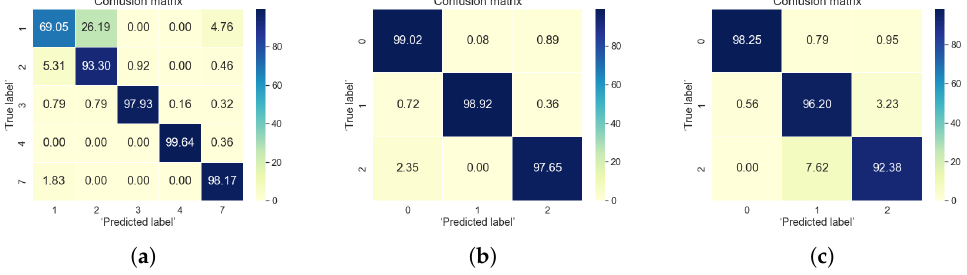
Figure 15. Confusion matrix for XGBoost algorithm using combined indoor and outdoor data. ( a ) User classification; ( b ) UCLA based classification; ( c ) Lubben-based